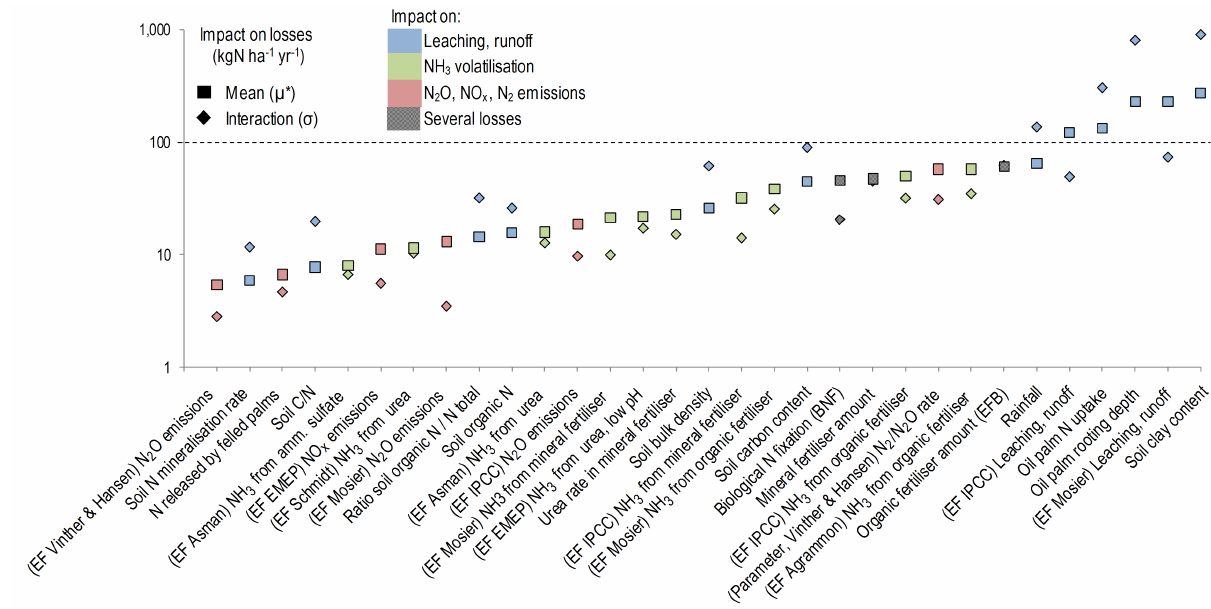
Figure 12. Average Morris indices for 31 variables of the 19 sub-models. The five variables with the highest influence ( µ ∗ > 100kg Nha − 1 yr − 1 ) were related with leaching and runoff losses (logarithmic scale). Variables were ranked by increasing mean sensi- tivity index ( µ ∗ ). The mean effect ( µ ∗ squares) was an estimation of the linear influence of the variable on losses. The interaction effect ( σ , diamonds) was an estimation of non-linear and/or interaction effect(s) of the variable on losses. Variables with µ ∗ <5kg Nha − 1 yr − 1 , i.e. 16 variables, are not represented. EF: emission factor; BNF: biological N fixation; EFB: empty fruit bunches, i.e. organic